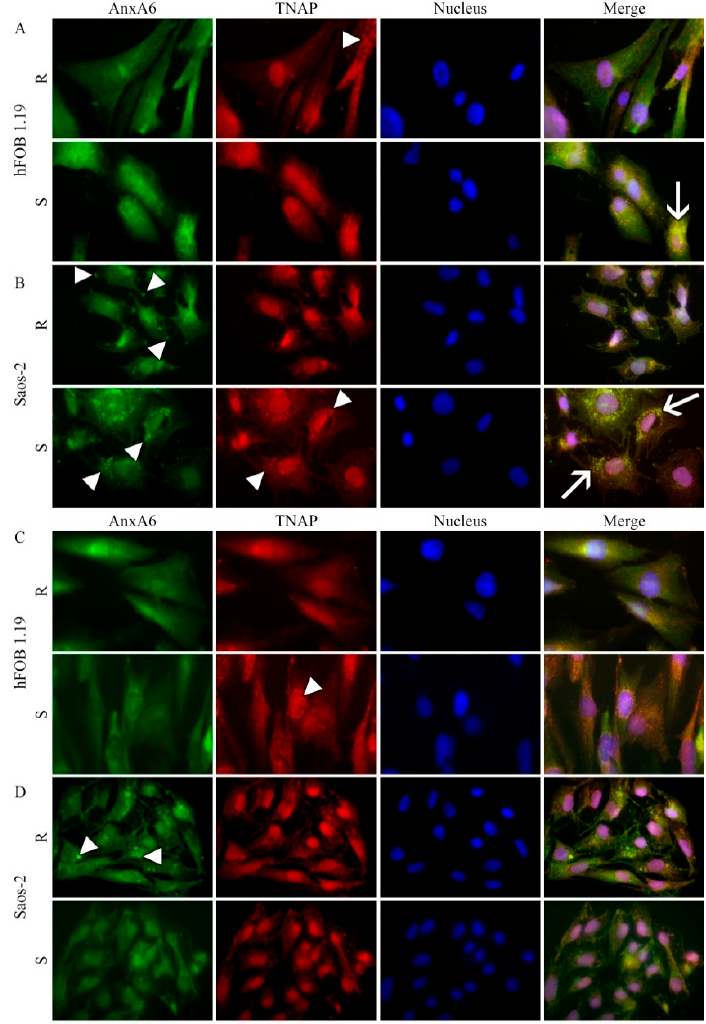
Figure 5. Co-localization of AnxA6 with TNAP in hFOB 1.19 ( A , C ) and Saos-2 ( B , D ) cells after treatment with 100 µ M levamisole ( A , B ) or 25 µ M K201 ( C , D ) in resting conditions (R) or after seven-day stimulation with AA and β -GP (S). The cells were incubated with appropriate antibodies: mouse monoclonal anti-AnxA6 followed by goat anti-mouse IgG-FITC (green), rabbit polyclonal anti-TNAP followed by goat anti-rabbit IgG-TRITC (red) and DAPI for nucleus (blue) and observed under an Axio Observer.Z1 FM (Carl Zeiss, Poznan, Poland) with Phase contrast and appropriate fluorescent filters, magnification at 630×. Arrowheads indicate protein accumulation in vesicular and/or cluster structures. The yellow color and arrows on the merge images indicate AnxA6 co-localization with TNAP. Results of a typical experiment are presented.